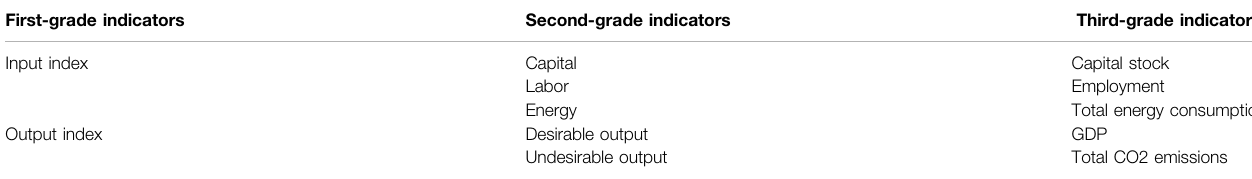
TABLE 1 | Measurement of input and output index by Energy TFP.